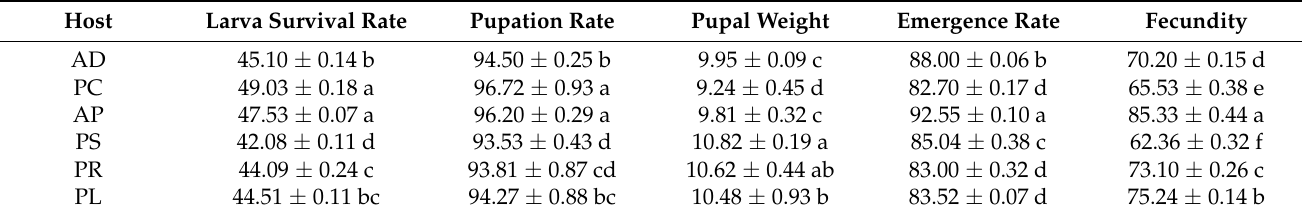
Table 2. Growth and development parameters of G. molesta fed on different hosts.